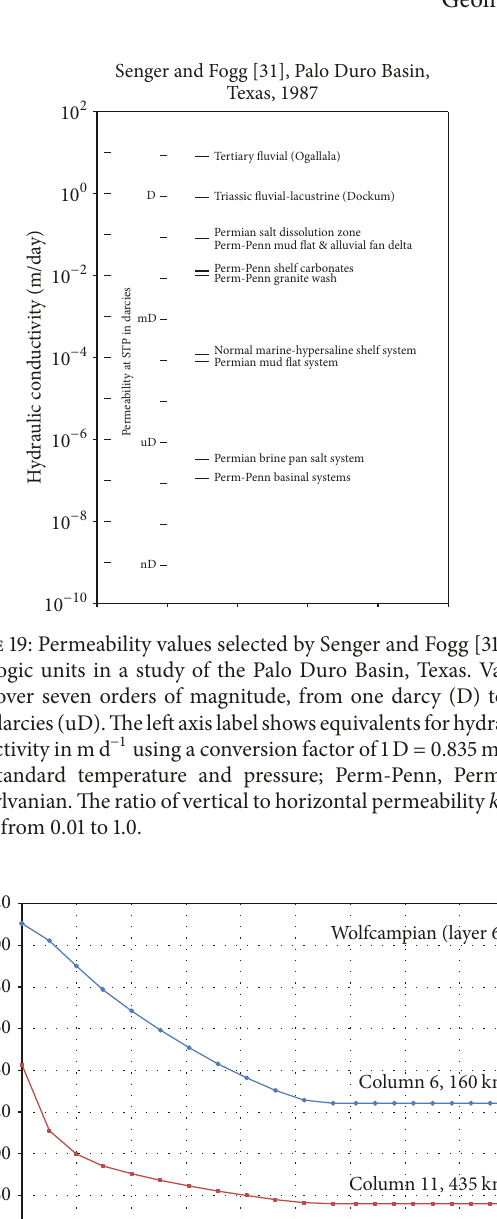
Figure 20: Head versus time for Wolfcampian cells in columns 6, 11, and 23 of the 27Ma model, showing that steady state is reached around 34.5 Ma, after 5.5 million years of simulated time. Head in meters above sea level for Figures